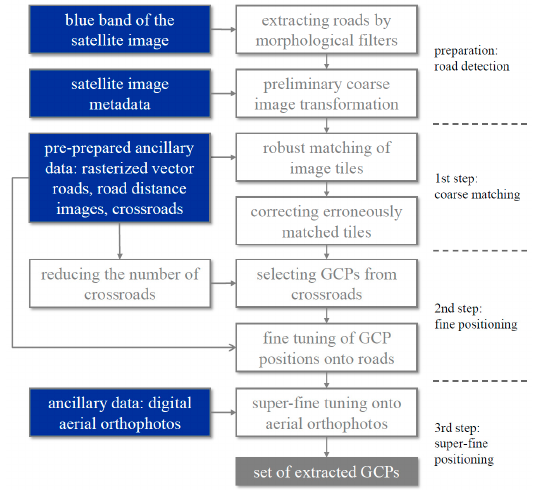
Figure 6. Workflow of the automatic GCP extraction sub-module, improved for VHR images such as WorldView-2 (the three-step algorithm). WorldView-2 (the three-step